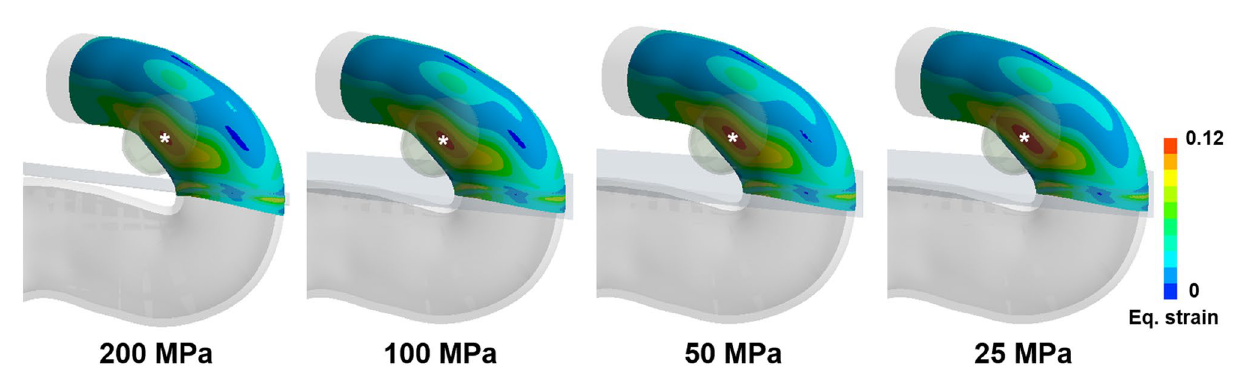
Figure 7. Example of strain contour change depending on Young’s modulus of the dura mater change. There is a difference in strain contour for various Young’s moduli of the dura mater. When Young’s modulus of the dura mater is 200 MPa, 100 MPa, 50 MPa, and 25 MPa, the max strain is 0.111, 0.112, 0.114, and 0.116, respectively. A white star (*) indicates the location of aneurysm formation site. The strain was extracted at the systolic